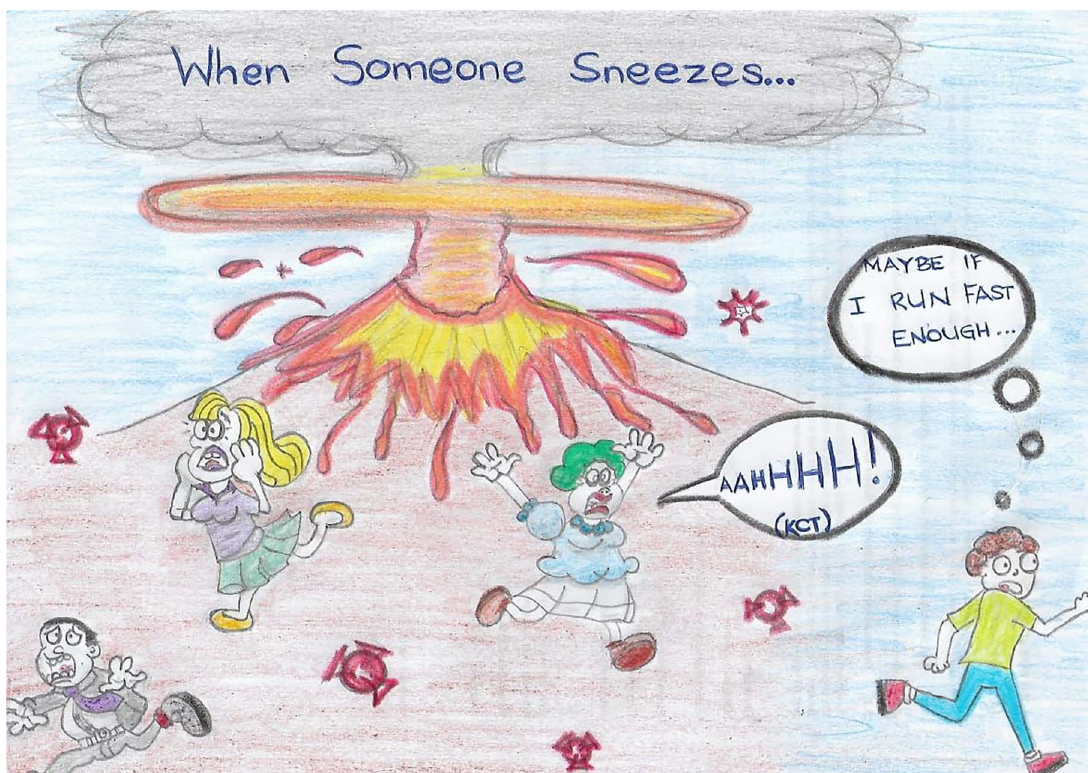
Figure 1. ‘When someone sneezes’ by Kwandile